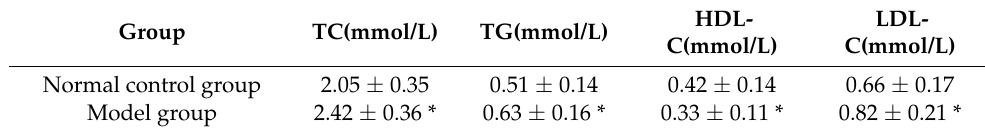
Table 3. Blood lipids in the normal control and model group rats after 4 weeks of modeling.